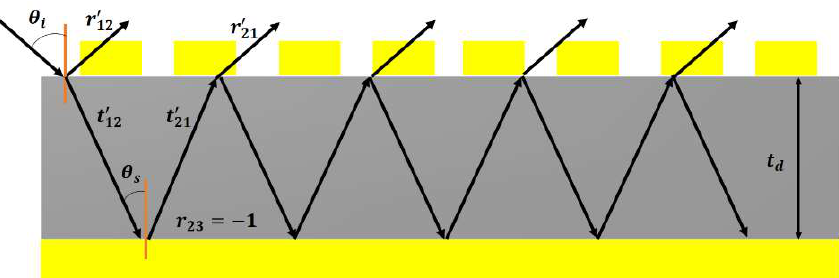
Figure 6. Illustration and schematic of the multiple-reflection model of the proposed MMA.